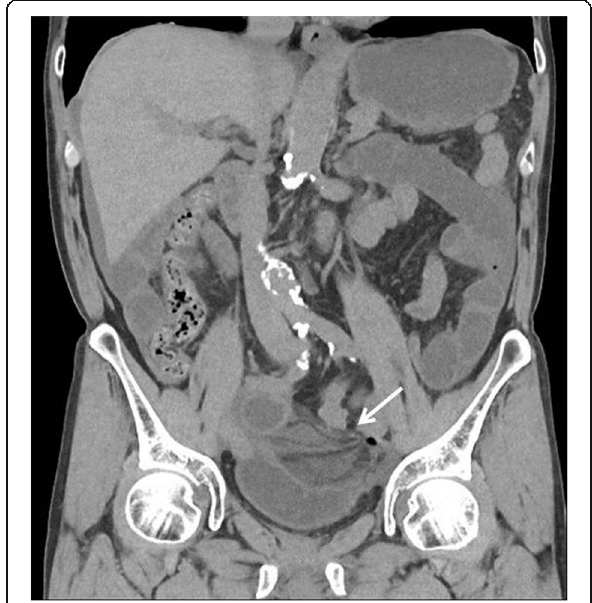
Fig. 1 Coronal image of non-contrast computed tomography showed thickened loops of small bowel with surrounding mesenteric edema (arrow) in the left lower quadrant